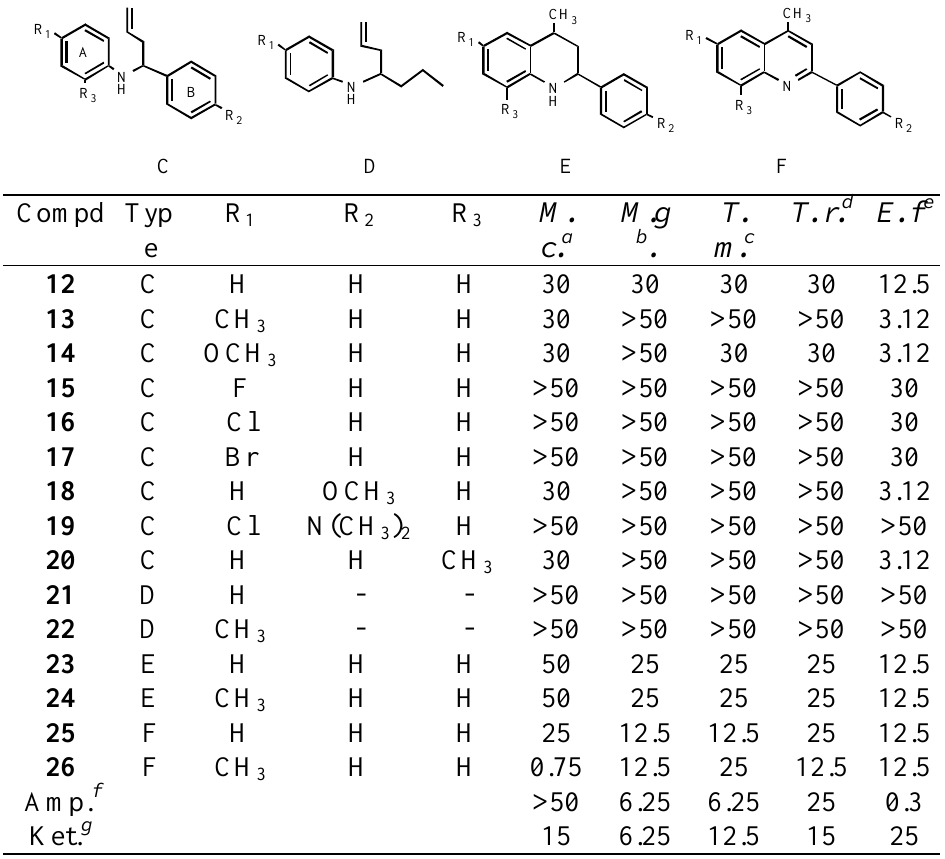
Table I. MIC values ( m g/mL) of homoallylamines, tetrahydroquinolines and quinolines acting against